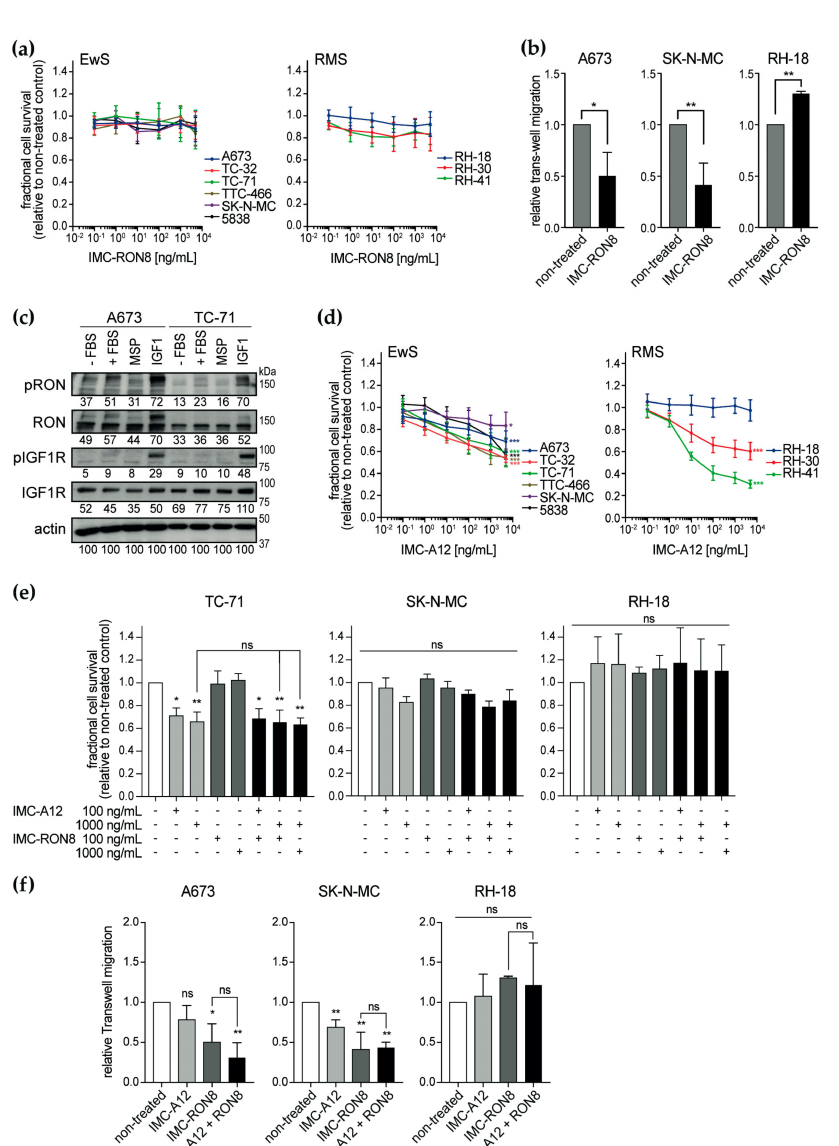
Figure 4. IMC-RON8 antibody inhibits migration but not proliferation of Ewing sarcoma cell lines in vitro. ( a ) IMC-RON8 does not significantly reduce monolayer cell viability of EwS and RMS cell lines. Cells were grown in standard conditions and treated as indicated. After 72 h, relative cell viability was measured by MTT assay. ( b ) IMC-RON8 impairs migration of Ewing sarcoma cells. Cells were cultured in serum-free medium, seeded into trans-well chambers containing 100 ng / mL IMC-RON8 where indicated and allowed to migrate towards 10% serum. Graphs represent mean ± SD of triplicate experiments. ( c ) RON is cross-activated by IGF1–IGF1R signaling but not vice versa. Cells were starved in serum-free medium for 24 h before stimulation with fetal bovine serum (FBS) (10%), MSP (400 ng / mL) or IGF1 (100 ng / mL) for 30 min. Following analysis of phospho-RON, blots were stripped and re-probed for total RON expression; numbers indicate densitometry readings relative to respective actin loading control. ( d ) Dose-response of the EwS and RMS cell lines to the anti-IGF1R antibody IMC-A12. Assays were performed as in ( a ); significances refer to maximum dose compared to non-treated cells. ( e ) Combined treatment with IMC-RON8 plus IMC-A12 does not result in synergistic e ff ects on cell viability. MTT assay was performed as in ( a ). Graphs ( a ), ( d ) and ( e ) represent the mean ± SD of at least three independent experiments. ( f ) Combined treatment with IMC-RON8 plus IMC-A12 does not reveal synergistic e ff ects on migration. Assays were performed as in ( b ) with 100 ng / mL IMC-A12 and 1000 ng / mL IMC-RON8 as indicated. Significance is indicated as p < 0.05 (*), p < 0.01 (**) and p < 0.001 (***), while ns indicates a non-significant p